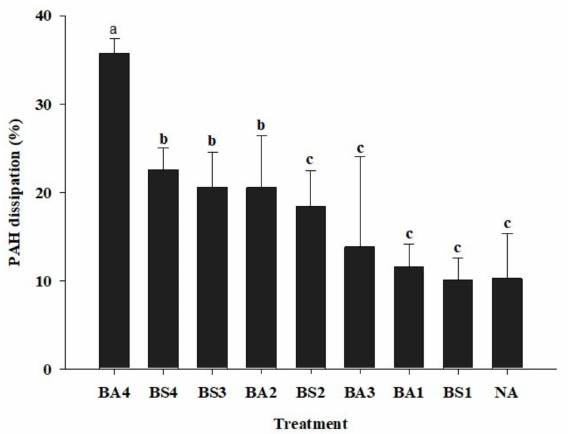
Figure 1. Average PAH dissipation rates of treatments after 8 months of incubation. Error bars represent standard deviations. Letters designate groups with no statistically significant